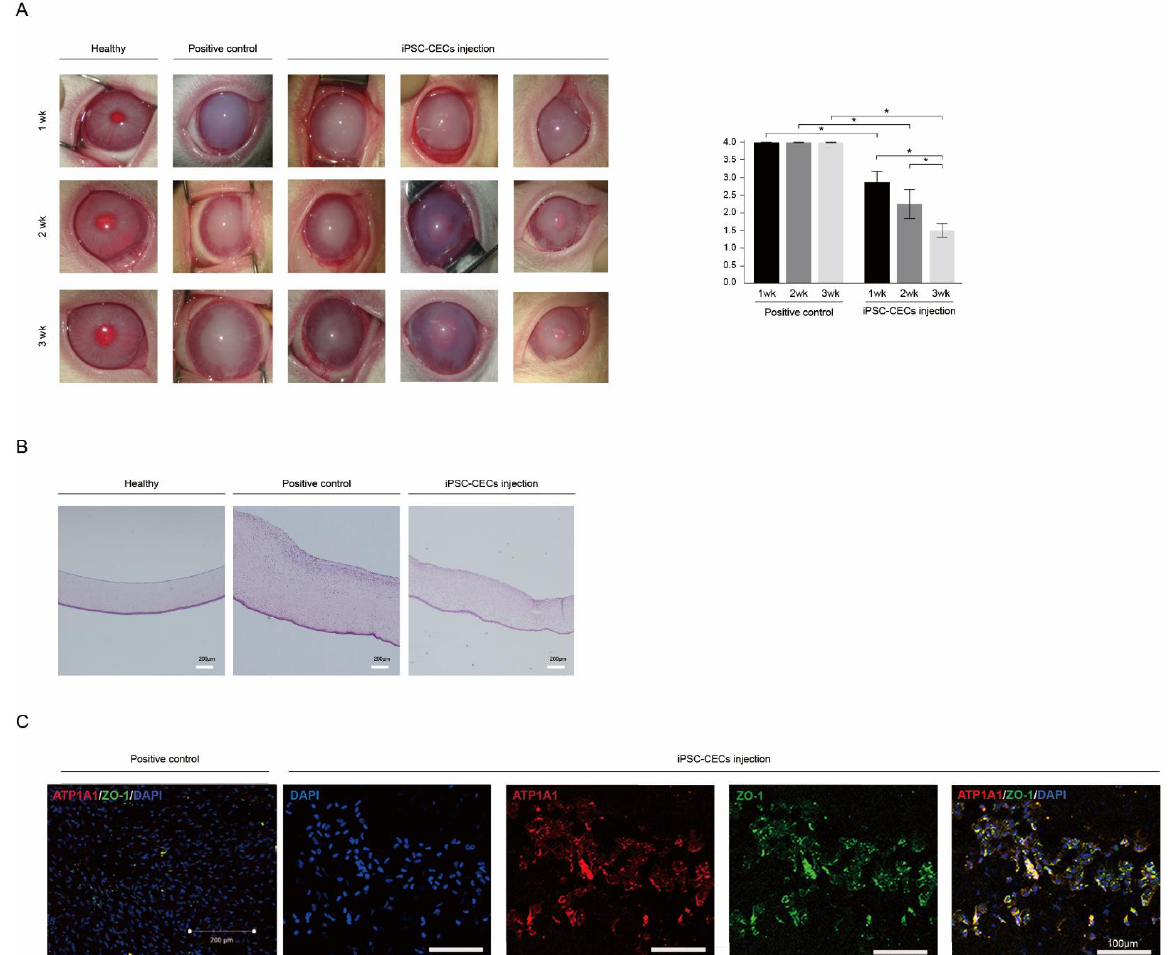
Figure 4. Transplantation of iPSC-derived CECs into a corneal endothelial dysfunction rabbit model. ( A ) Ocular observation and numerical data at 1, 2, and 3 weeks after transplantation of iPSC- derived CECs. Compared with the non-transplanted control, cloudy corneas were clear in the trans- planted eyes after 1 week and the effect increased over time (* p < 0.05; n = 6). Corneal opacity was evaluated on a scale of 0 – 4 (0 = none; 1 = mild turbidity, iris texture evident; 2 = moderate turbidity, iris texture unclear; 3 = severe turbidity, pupil faint; and 4 = severe turbidity, pupil not visible). ( B ) The corneal thickness of the cell transplant group was observed histologically using H & E staining. The cornea of the transplanted group (right) is thinner compared with the non-transplanted control group (middle) , which closely resembled the healthy cornea (left). Scale bars = 200 μm. ( C ) Immuno- histochemistry for the detection of human CEC markers (ATP1A1 and ZO-1) in the corneas of trans- planted and non-transplanted groups. ATP1A1 and ZO-1 were broadly expressed in the cornea of the transplant group, but not in the non- transplant control group. Scale bars = 200 or 100 μm. 2.5. Efficient Differentiation of iPSCs into CECs Next, we investigated ways to increase the efficiency of the CEC differentiation pro- cess. First, we determined the differentiation efficiency by replacing the coating material from the FNC mixture with vitronectin (VTN) for the CEC differentiation step. SOX2 ex- pression in the FNC mixture was significantly higher than that in VTN at 2, 4, and 6 days of CEC differentiation ( p < 0.05) (Figure 5A). COL8A1 and AQP1 expression in the VTN was significantly higher than that in the FNC mixture at 6 days of CEC differentiation ( p